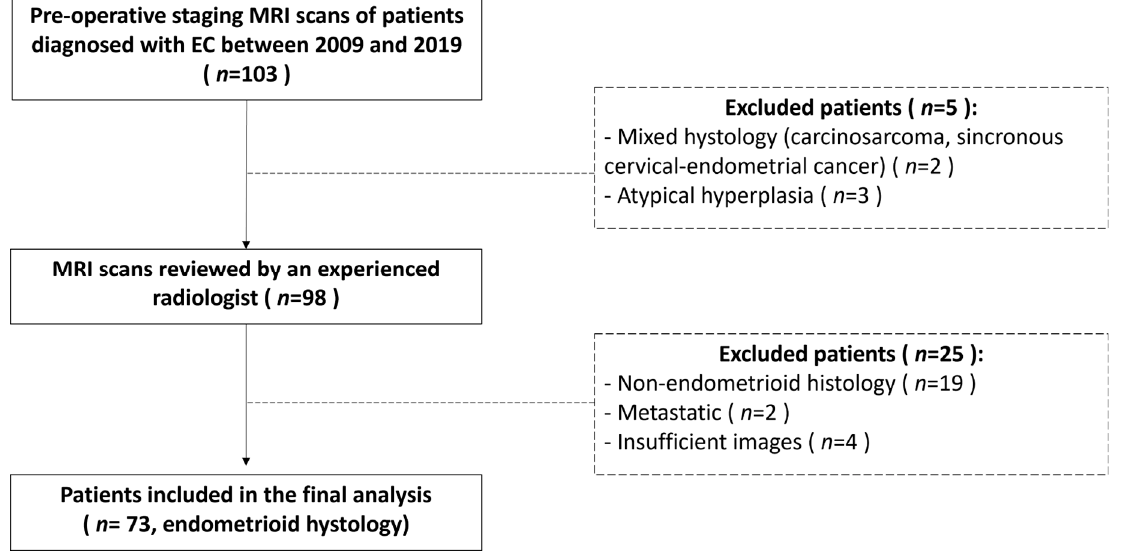
Figure 3. Flow chart describing patients’ selection process and exclusion criteria for the training set.